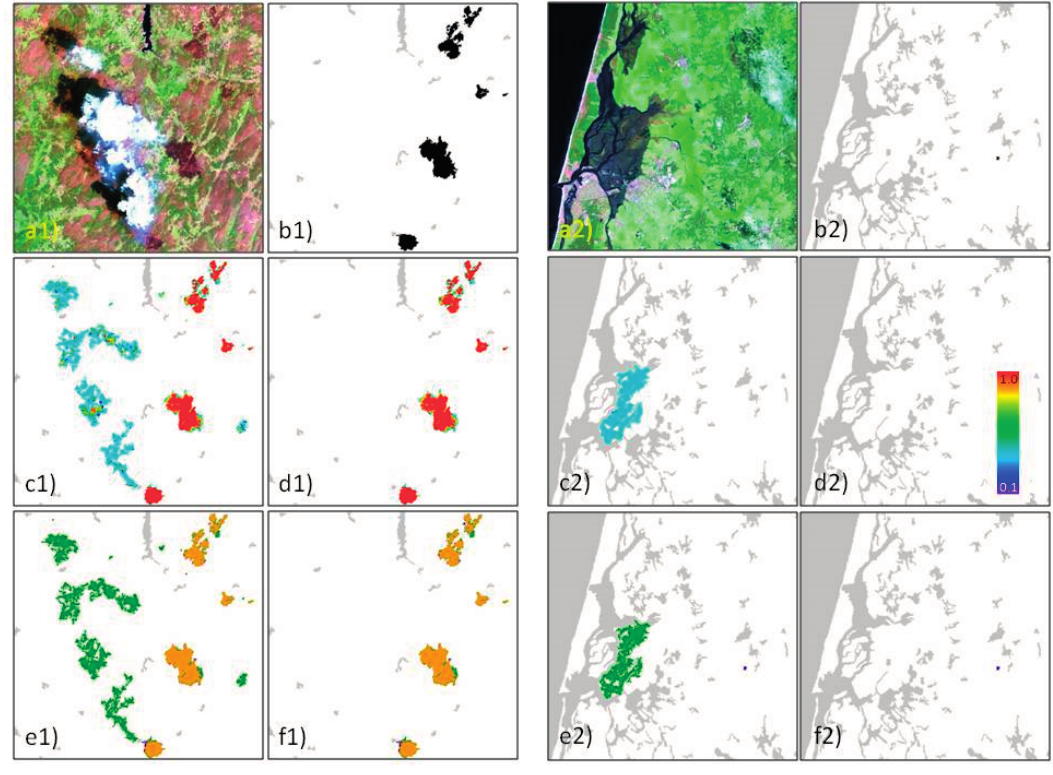
Figure 12. Two cuts relevant to the TM frame 204/032: ( a1 , a2 ) the false color composite of the TM image (R-G-B 5-4-3); ( b1 , b2 ) the reference maps (black = burned, white = unburned, grey = masked); ( c1 , c2 ) the fuzzy score maps obtained with only optical data; ( d1 , d2 ) the fuzzy score maps obtained with optical + SAR data; ( e1 , e2 ) the accuracy maps corresponding to (c1,c2); ( f1 , f2 ) the accuracy maps corresponding to (d1,d2). Each cut covers an area of about 30 km × 30